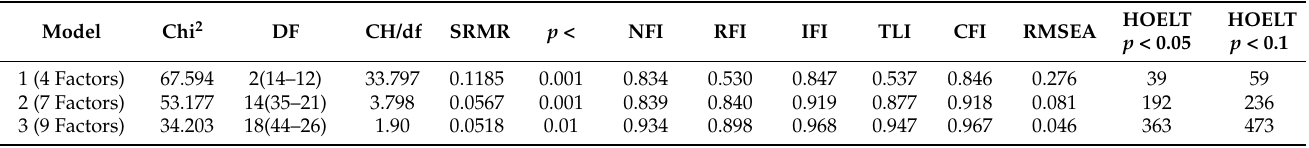
Table 3. Models of structural linear results of the